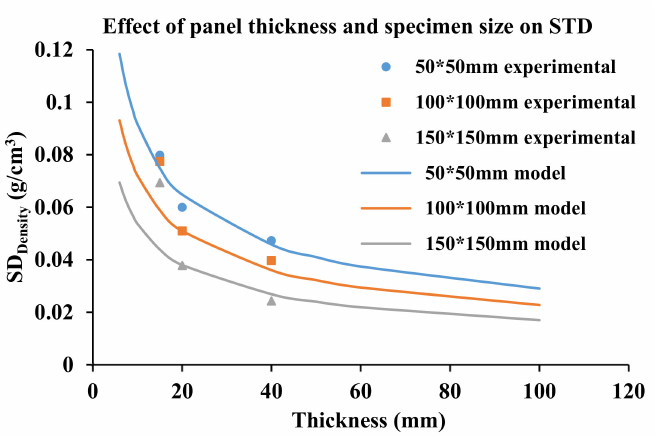
Figure 7. Density variability of BFC with panel thickness and specimen size.